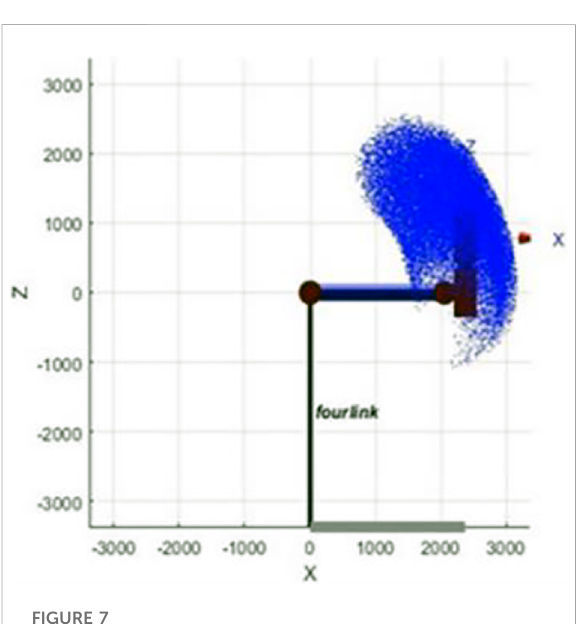
FIGURE 7 Spatial cloud diagram of the ZOX surface motion.